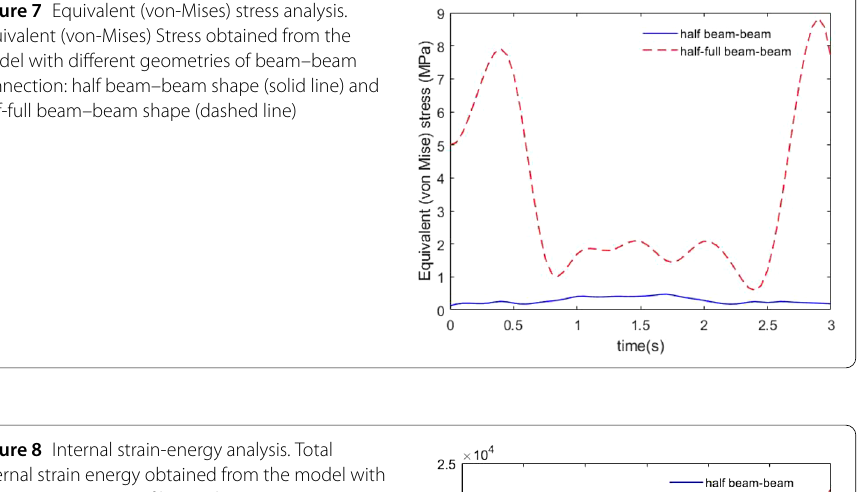
Figure 8 Internal strain-energy analysis. Total internal strain energy obtained from the model with different geometries of beam–beam connection: half beam–beam shape (solid line) and half-full beam–beam shape (dashed line)